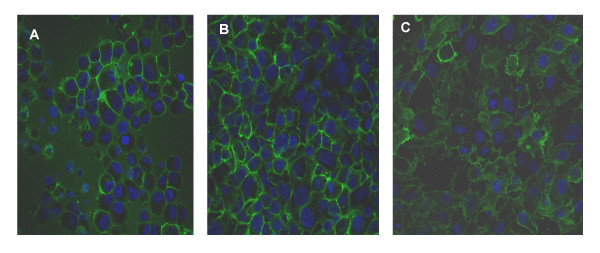
Expression of EGFR, α2/β1 integrin in Capan-1 cells. Cells were cultured on Transwell inserts, and confocal immunofluorescence microscopy performed following incubation with primary antibodies against EGF-R (A), α2 integrin (B) and β1 integrin (C). Negative controls with primary antibody omitted did not show a detectable signal.